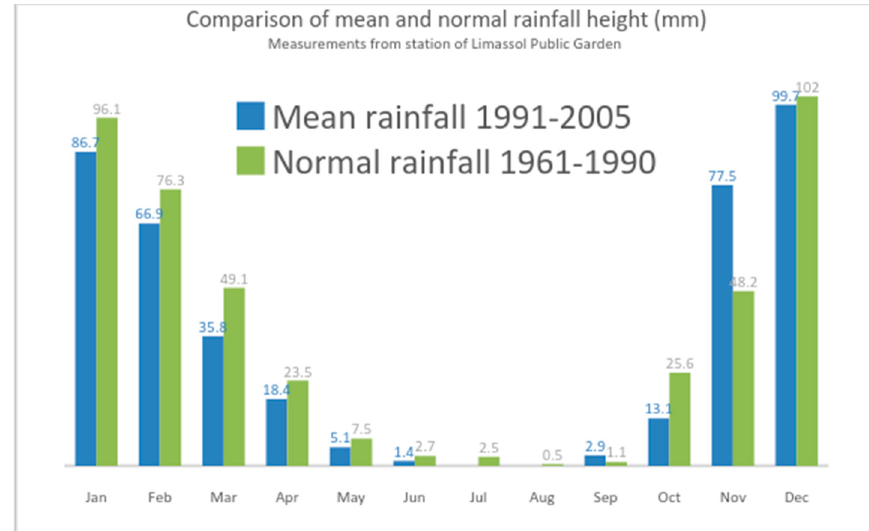
Figure 1. Comparison of mean and normal rainfall height (mm) in Limassol between years 1991–2005 and 1961 to 1990 (data from